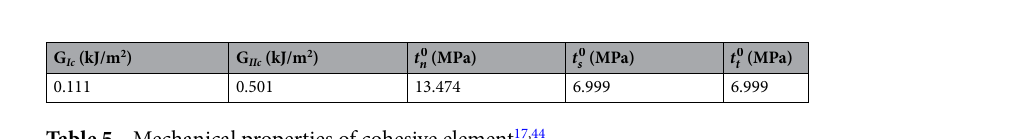
Table 5. Mechanical properties of cohesive element 17,44